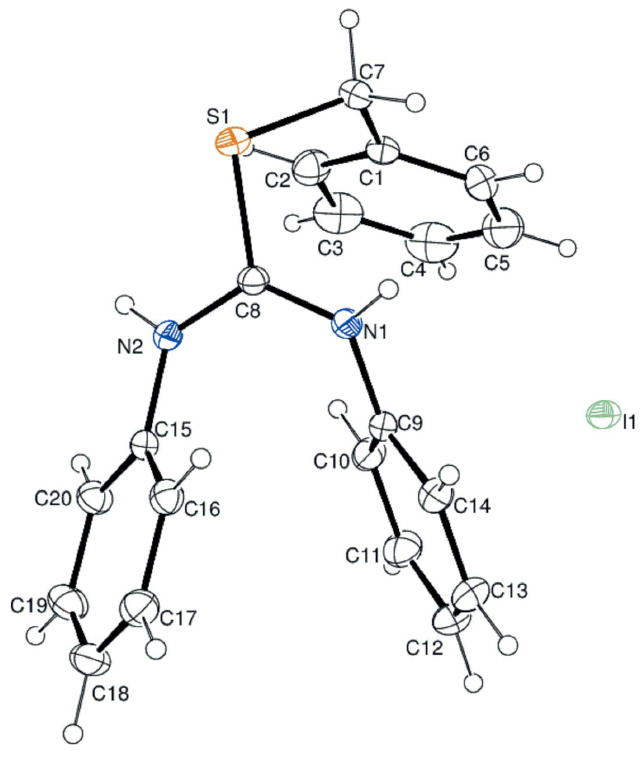
Figure 1 The molecular structure of the title compound with displacement ellipsoids drawn at at the 30% probability